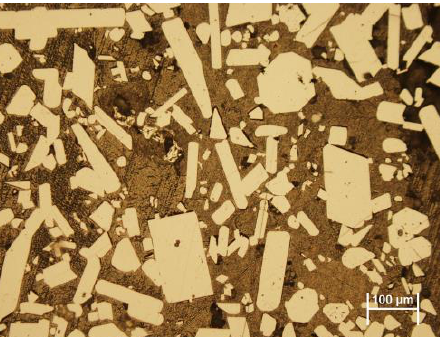
Table 2. Results of the XRD analysis — phase composition of the sample. Ref. Code